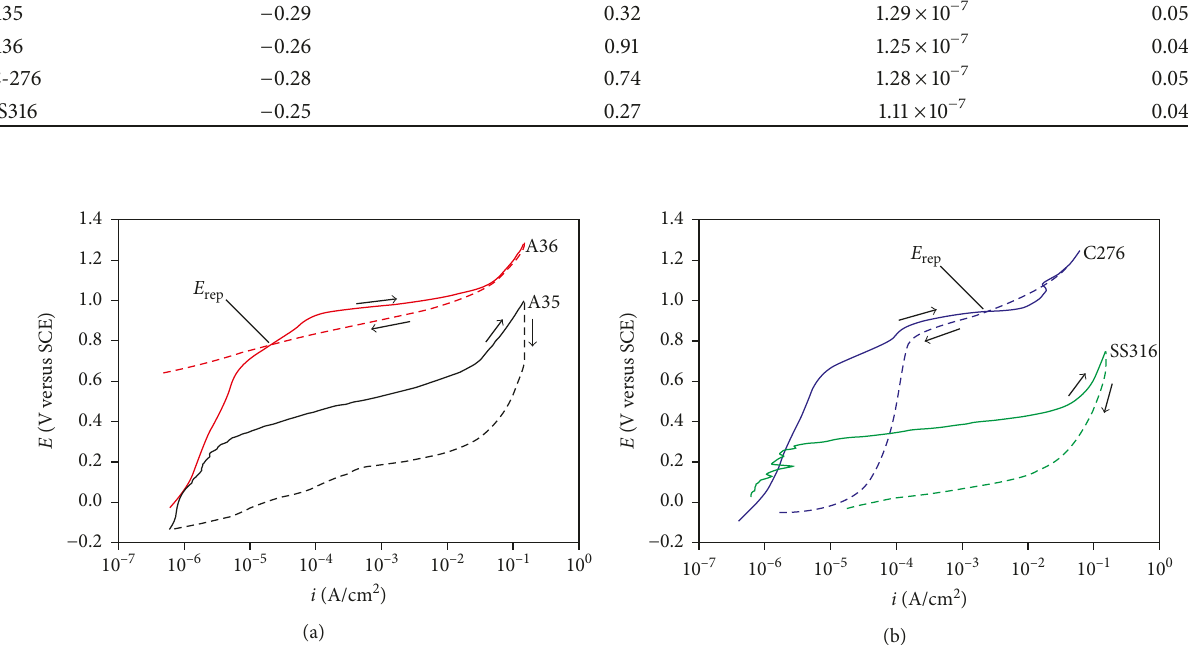
Table 2: Electrochemical parameters for HEAs A35 and A36 and commercial alloys C-276 and SS316 in 3.5wt.% NaCl solution at 25 ° C. Alloy E corr (V versus SCE) E bre (V versus SCE)